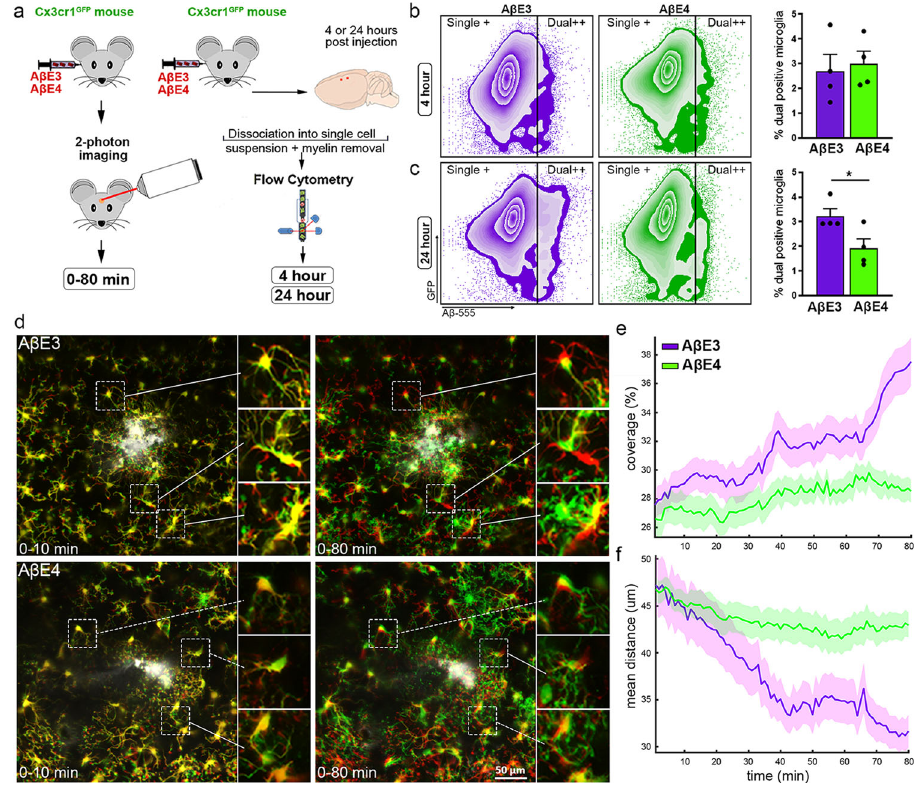
Fig. 3 Microglial interaction with A β is affected by APOE isoform. Cx3cr1 GFP mice were infused with Hi-Lyte Fluor 555-labeled A β (A β − 555) preincubated with native E3 or E4. a Experimental design. b , c Four or 24 h post-injection the cortex surrounding the injection site was dissociated into a single cell suspension and used for fl ow cytometry ( b , c ) and FACS (experiment shown on Fig. 4). Flow cytometry zebra plots represent live microglia cells from injected mice that are GFP high /A β − 555 low and are counted as single + cells or GFP high /A β − 555 high cells counted as dual + cells. Flow cytometry zebra plots from 4 h ( b ) and 24 h ( c ) time points and bar plots correspond to the percentage of dual-positive microglia cells in A β E3 (purple) and A β E4 (green) groups at 4 and 24 h. p = 0.0372 by two-tailed unpaired t -test. n = 4 mice/group. Bars represent mean ± SEM. d – f Two-photon imaging was used to track microglia movement in real time. d Representative fi elds of view from A β E3 (top row) or A β E4 (bottom row) infused mice. Time series are color- coded with infused A β as white; and initial time point in red and later time points in green as indicated on the panel, (0 – 10 or 0 – 80 min) with yellow representing the overlap between timepoints. Inserts show details of individual cells demonstrating the extent of migration and directionality of the cellular processes. Scale bar = 50 µ m. e Percent coverage of infused A β by microglial processes computed from channel overlap. f Change of mean distance from microglia to infusion site over time for A β E3 (purple) and A β E4 (green) groups. The standard error within each group is plotted as a bounded line with mean as center line. n = 4 in vivo two-photon imaging in Cx3cr1 GFP mice injected with A β E3 or A β E4 (see Fig. 3a for the design). We injected the same volume and assessed the biodistribution post-injection by acquiring in vivo three-dimensional z-stacks (Supplementary Fig. 5d). For each animal, ZT-stack images were analyzed to quantify the microglial migration towards the infusion site and microglial coverage of the infusion site over time (Fig. 3d – f and Supplementary Fig. 5e, f). The representative images of the time series are color-coded with the initial timepoint (0 min) in red, later timepoints (10 or 80 min) in green and the infused A β in white (Fig. 3d and Supplementary Fig. 5e, f). The time series (Fig. 3d, insets) show clear separation of the green and red labels in the A β E3 infusion group (Supplementary Movie 1), indicative of faster migration and better coverage of the infused A β compared to A β E4 (Supplementary Movie 2). In contrast, the time series from the mice infused with A β E4 demonstrated a visible overlapping — yellow-colored — representing a slower migration velocity and less microglial A β coverage. The percent coverage by the microglial processes over time was computed as the increase of the green channel intensity over the infusion site and shown on Fig. 3e. The change in the distance from microglia to the infusion site is presented on Fig. 3f. Microglia were able to